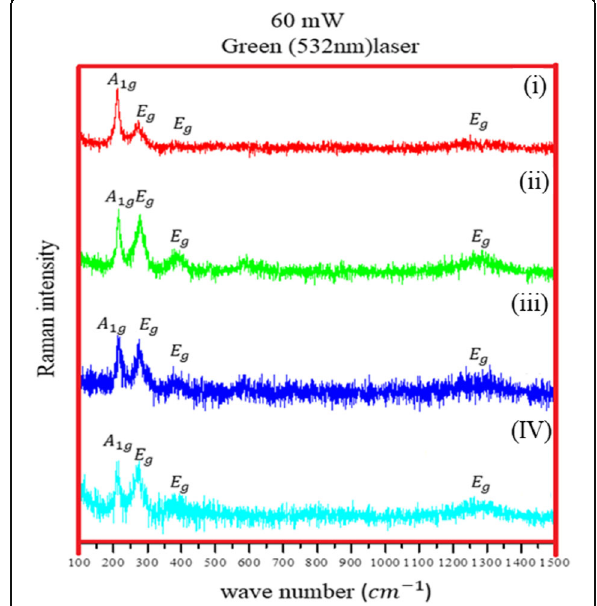
Fig. 6 Raman Spectra of (i) FeNCs-0, (ii) FeNCs-2, (iii) FeNCs-4, (IV) FeNCs-6 at 60 mW laser power with Green laser